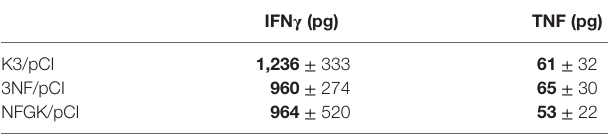
TaBle 3 | The percentage of cytotoxic T cells (Tc) and helper T cells (Th) and their subpopulations in mice spleens. Dna vaccine Percentage of the indicated cells in the pull of isolated splenocytes Tc